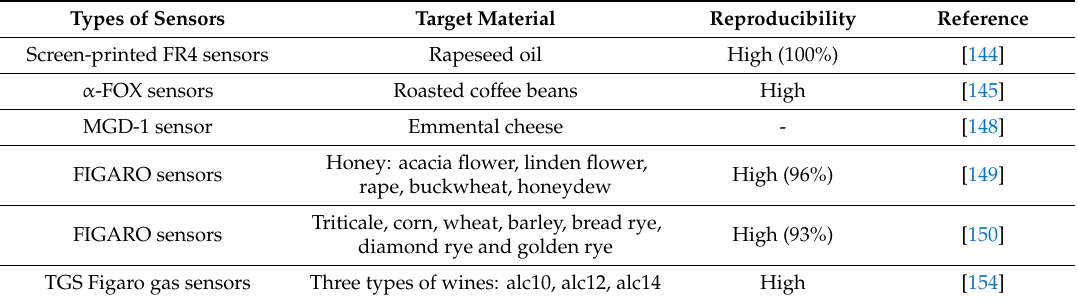
Table 8. Summary of the above-mentioned works on e-nose on the basis of some vital parameters.